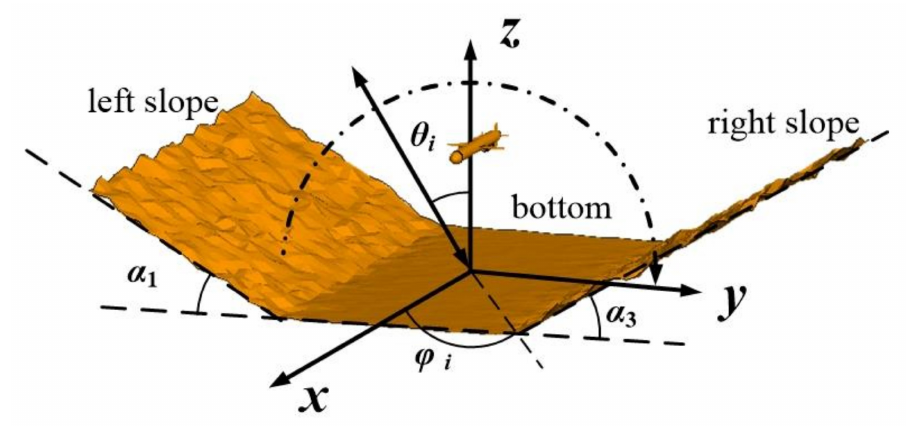
Figure 19. The geometry of a missile-like target above composite rough surface for monostatic